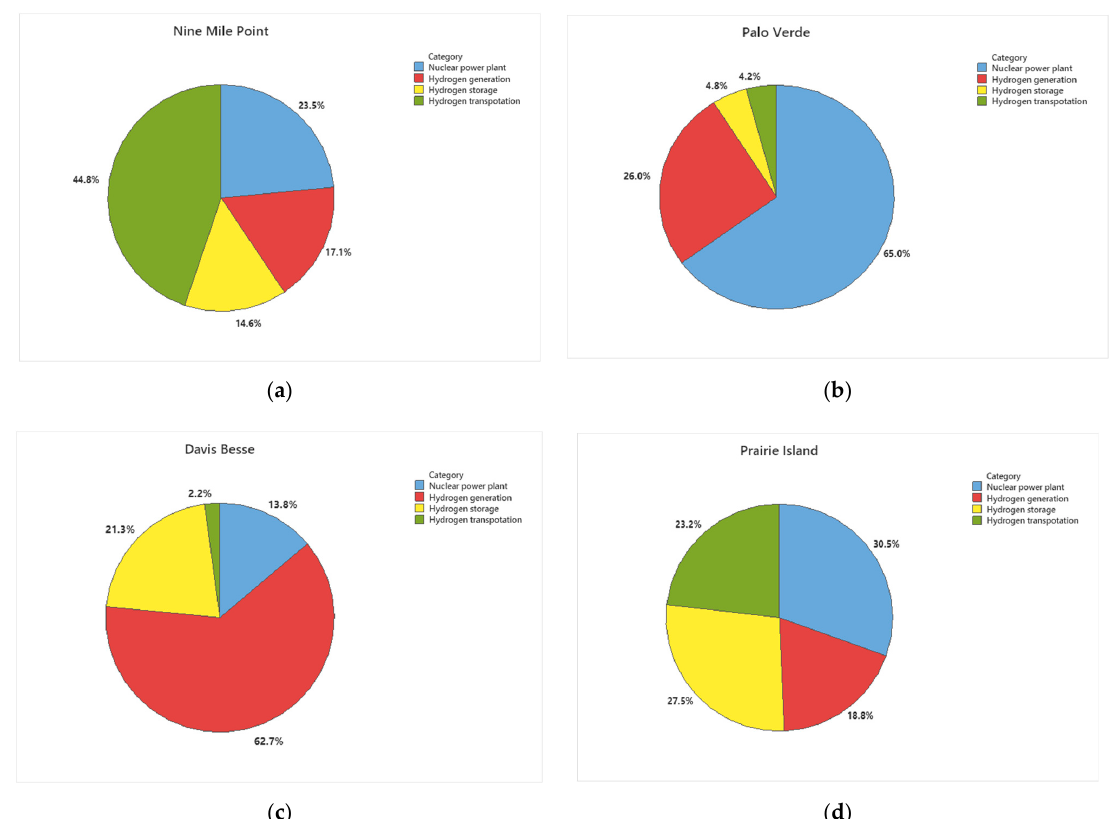
Figure 2. Percentage contribution of the nuclear power plant, H 2 generation, storage, and transpor- tation cost for ( a ) shows percentage contribution of H 2 generation steps for Nile Mile Point nuclear power plant, ( b ) shows percentage contribution of H 2 generation steps for Palo Verde nuclear power plant ( c ) shows percentage contribution of H 2 generation steps for Davis Besse nuclear power plant and ( d ) shows percentage contribution of H 2 generation steps for Prairie Island nuclear power plant.